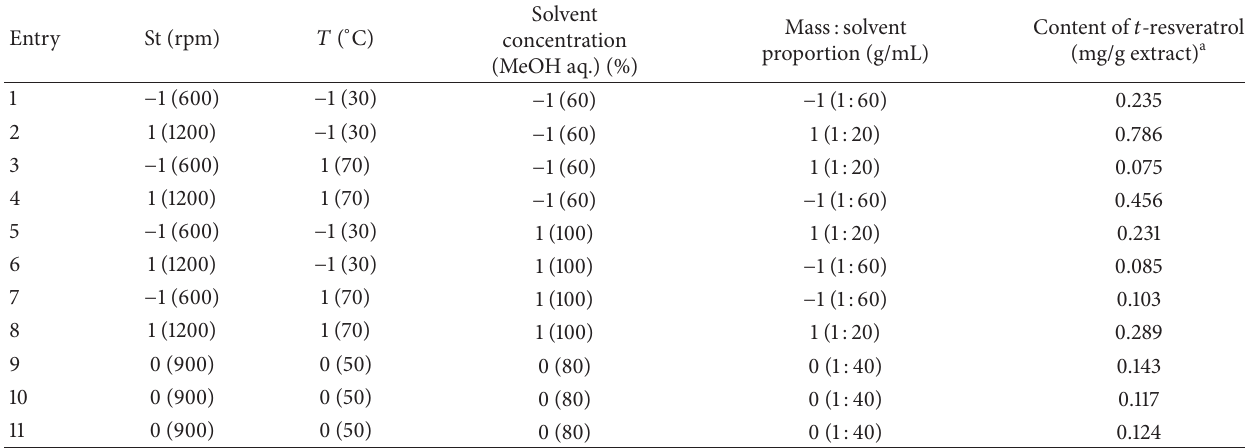
Table 2: Fractional factorial design (FFD) model totalizing 11 experiments aiming at the optimization of trans -resveratrol extraction in mg/g extract, by the microwave-assisted